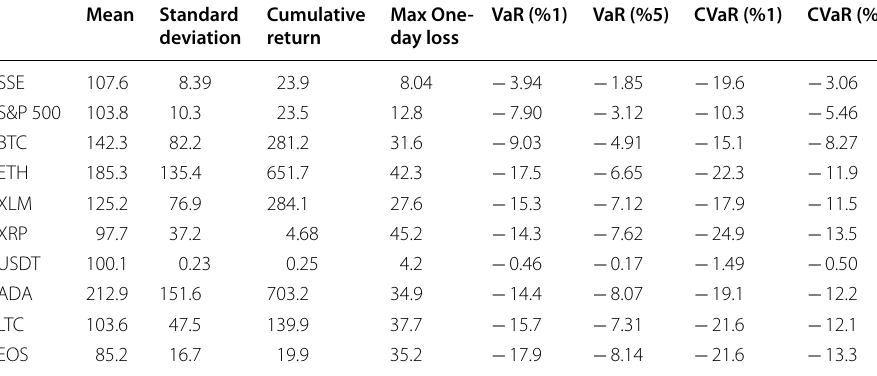
Table 9 VaR and CVaR